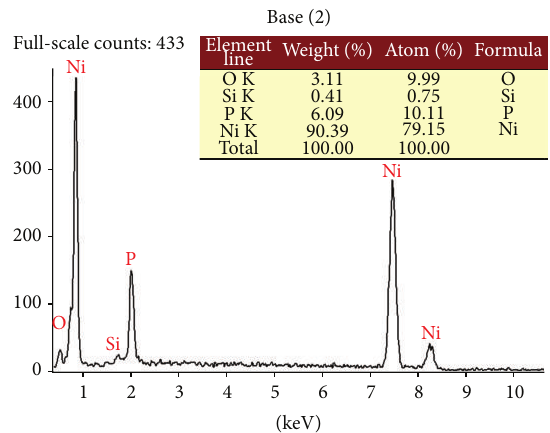
Figure 23: EDX diffractogram showing the % of elements present on the EN-coated Mg sample with 0.5%